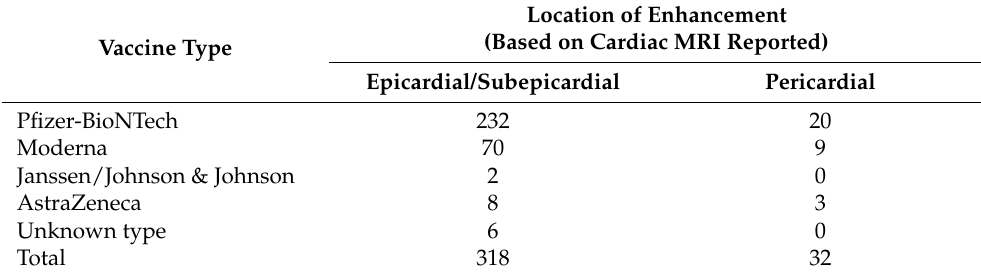
Table 2. Cardiac MRI Findings of Study Cases based on the vaccine’s type. Location of Enhancement (Based on Cardiac MRI Reported) Vaccine Type Epicardial/Subepicardial Pericardial Pfizer-BioNTech 232 20 Moderna 70 9 Janssen/Johnson & Johnson 2 0 AstraZeneca 8 3 Unknown type 6